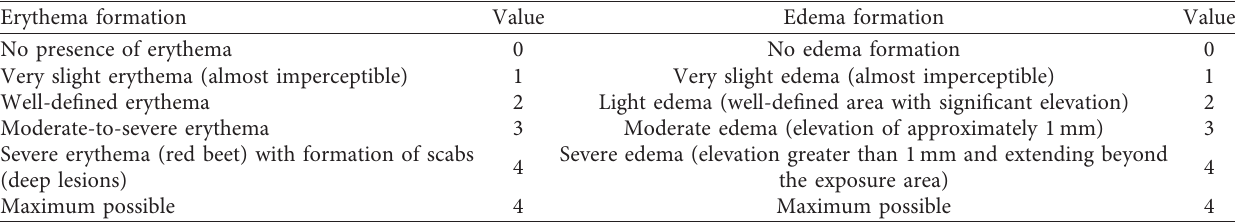
Table 5: Evaluation scale of dermal reactions (erythema and